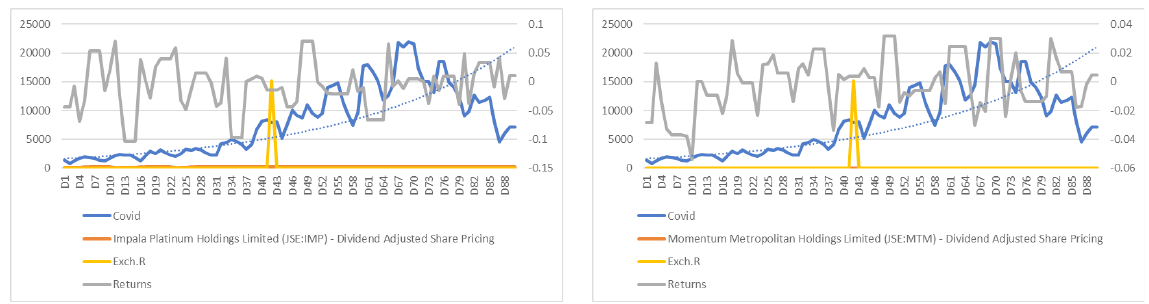
Figure 7. Impala Platinum Limited Figure 8. Momentum Metropolitan Holding